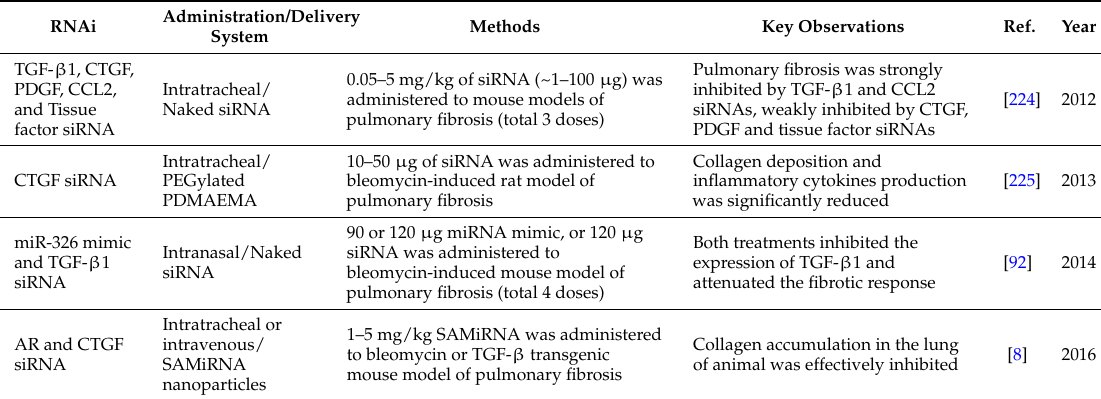
Table 5. Selected in vivo studies of using RNAi therapy on pulmonary fibrosis.